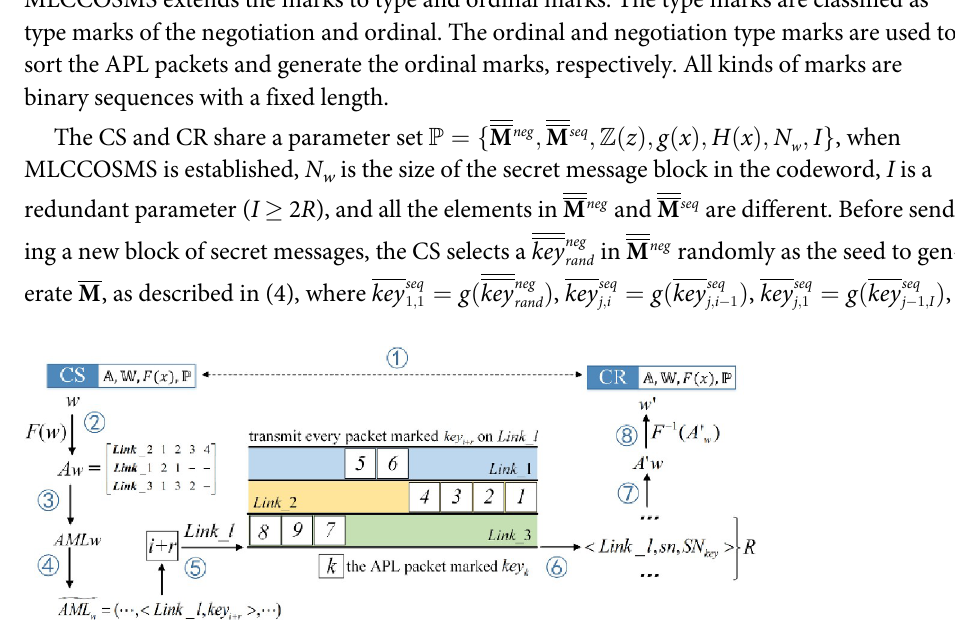
Fig 5. Process of covert codeword transmission of the